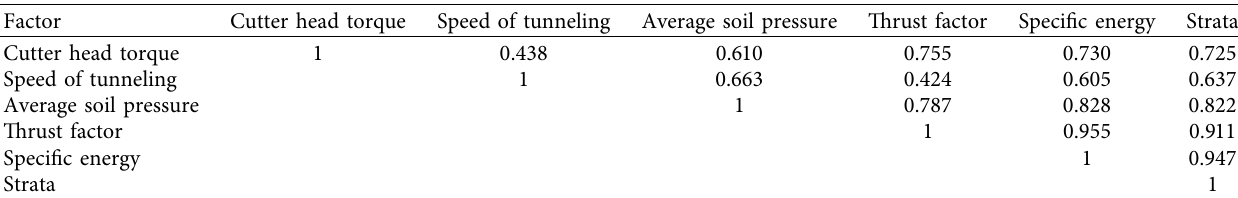
Figure 5: Time domain diagram of tunneling specific energy and partially enlarged view. Table 4: Pearson correlation